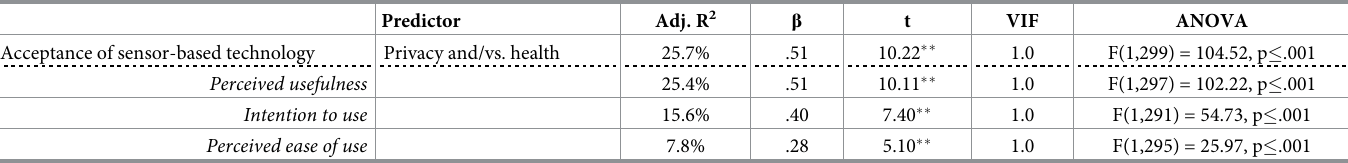
Table 2. Results of a regression analysis for the acceptance of sensor-based technology in home environments ( N = 312; �� p � .001; VIF = variance inflation factor < 10). Predictor Adj. R 2 β t VIF ANOVA Acceptance of sensor-based technology Privacy and/vs. health 25.7% .51 F(1,299) = 104.52, p � .001 Perceived usefulness 25.4% Intention to use Perceived ease of